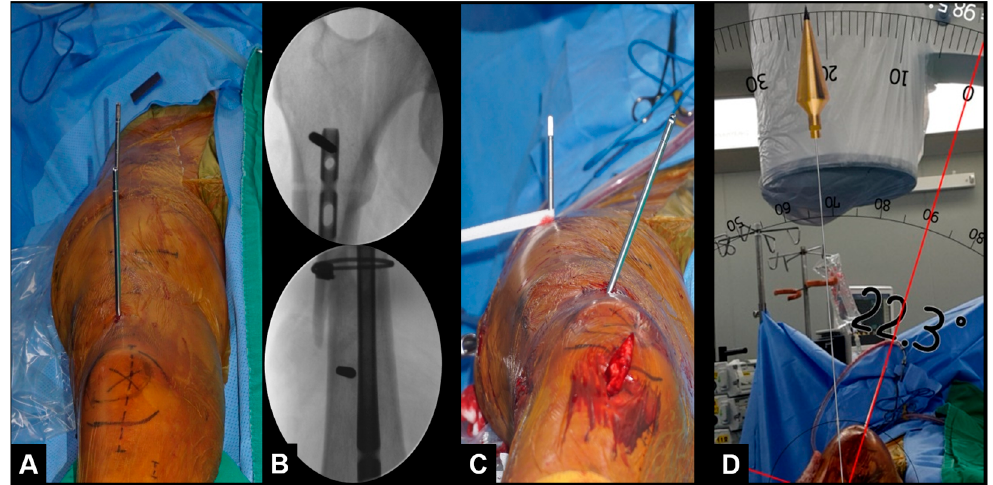
Figure 2. ( A , B ) Two parallel Schanz pins placed above and below the nonunion without interfering with the nail; ( C ) internal rotation of the distal segment after removal of the previous nail; ( D ) the smartphone application measured a 22°